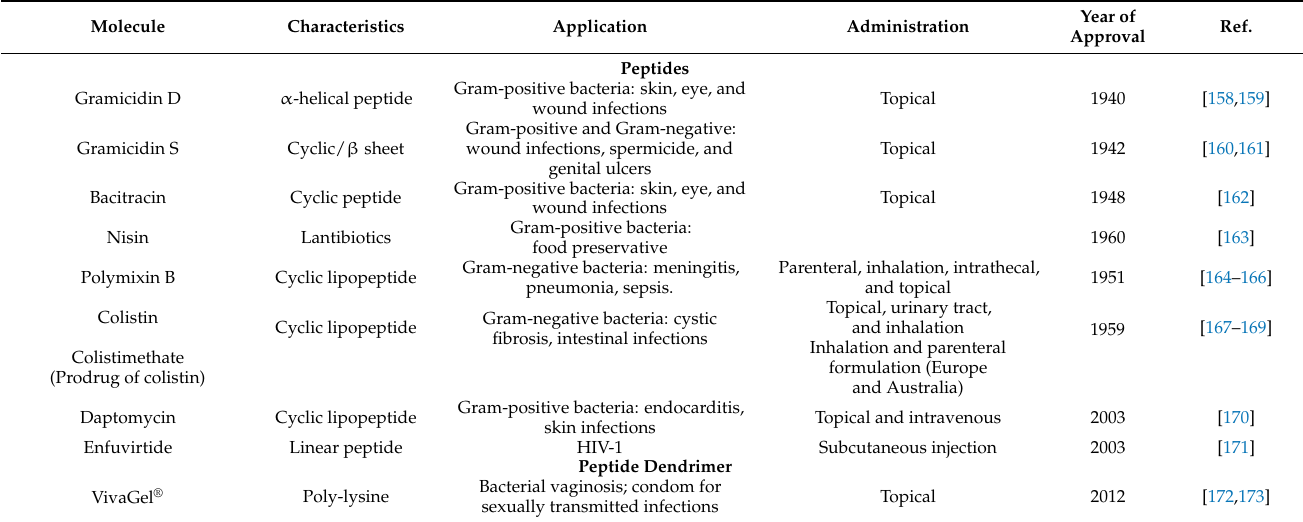
Table 1. Clinical applications of peptides, dendrimers, and peptide